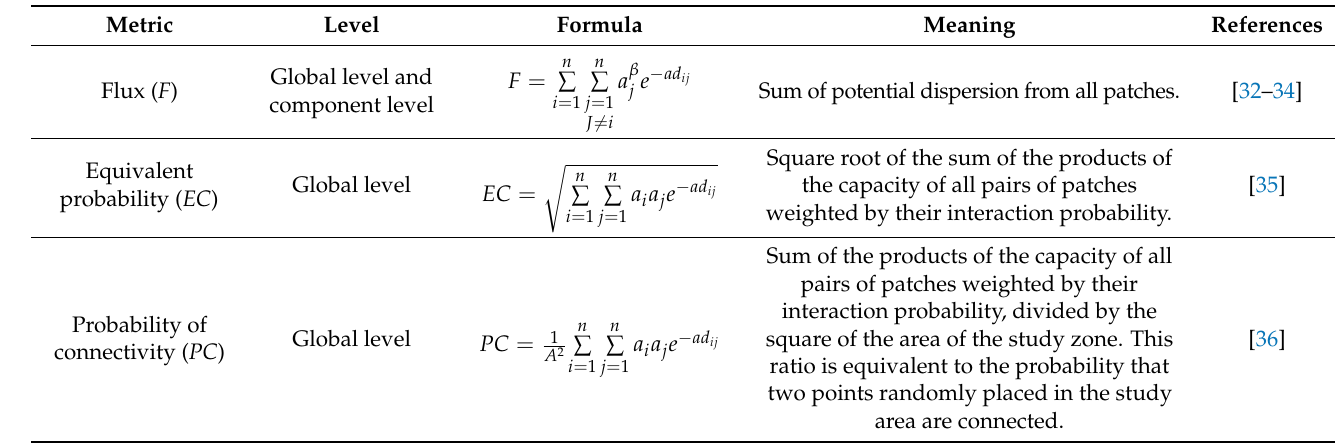
Table 2. Description of connectivity metrics analyzed according to Folt ê te et al.